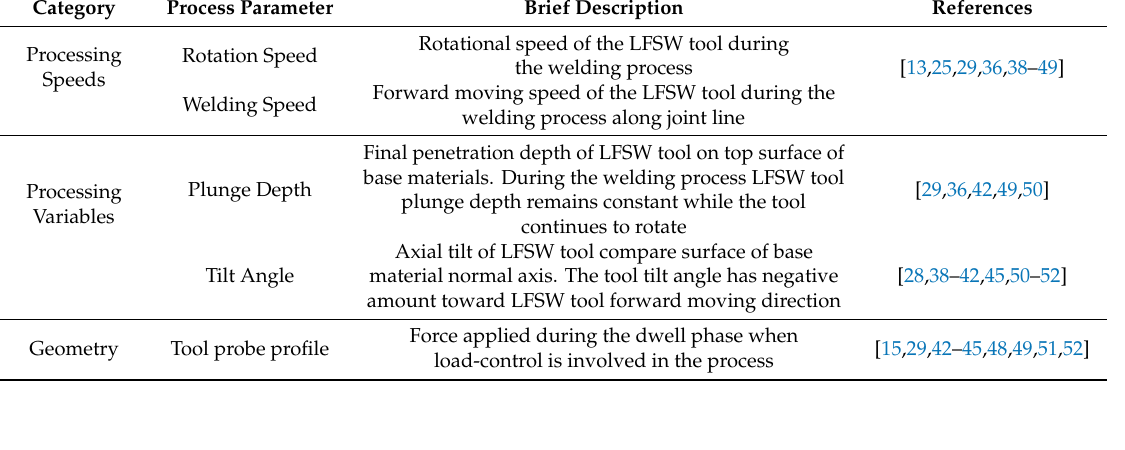
Table 4. LFSW process parameters List.